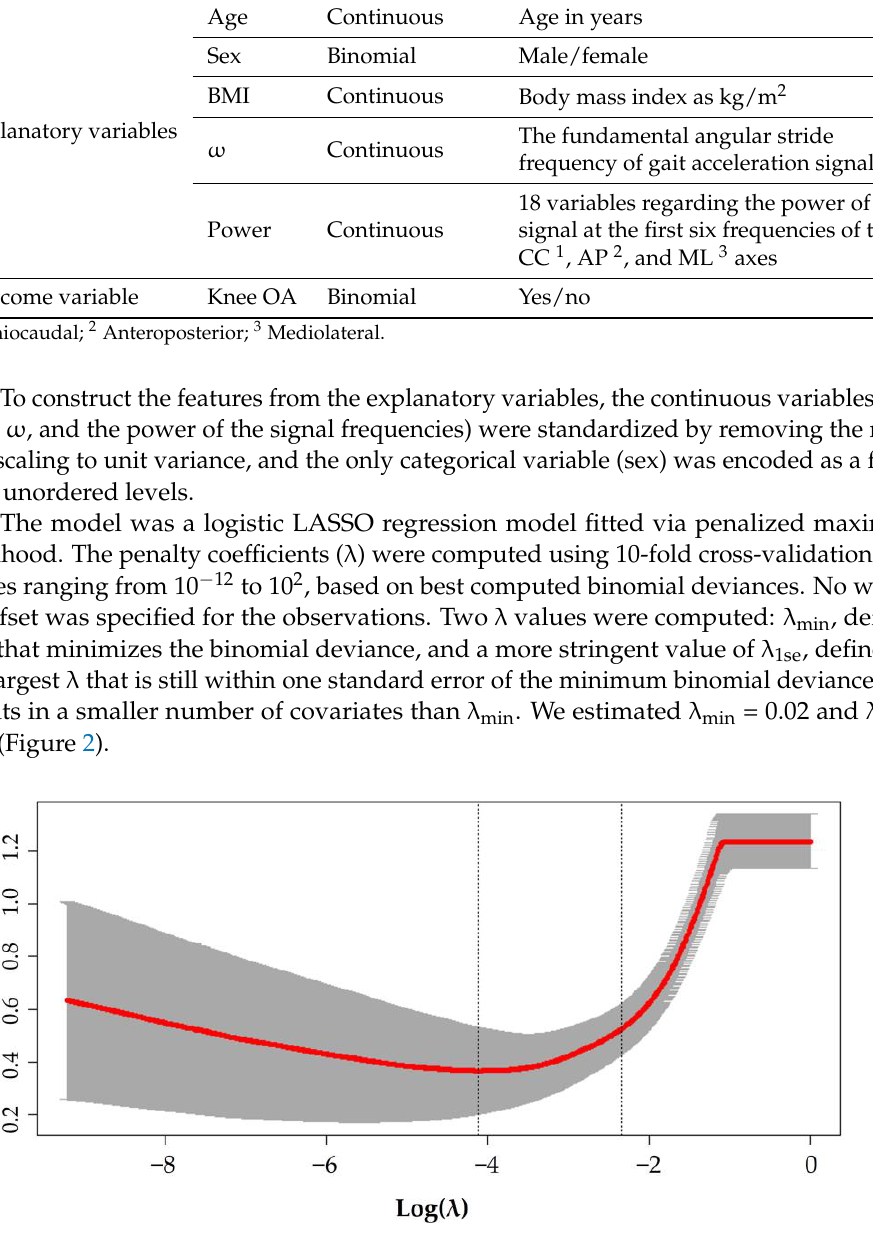
Figure 2. Cross-validation plot for the penalty coefficient ( λ ). Two vertical dashed lines correspond to the λ min and λ 1se to the left and right, respectively. The x-axis regards the logarithm of λ . The LASSO coefficients ’ 95% CI and p -values at a fixed value for the penalty param- eter ( λ = λ 1se ) were obtained using the method described by Taylor and Tibshirani [33]. Finally, the model ’ s performance in classifying the gait signals into osteoarthritic and non-osteoarthritic knees (patients vs. controls) was estimated by performing 10-fold cross- validation on divided data into 75% training and 25% validation sets. Subsequently, the mean and 95% CI were calculated for accuracy as the percentage of correctly classified instances out of all cases and Cohen’s Kappa as the measure of agreement between the actual and classified labels. We have also calculated the accuracy and Kappa for a separate logistic LASSO regression model with potential confounder variables (age, BMI, and ω) to ascertain the superior ability of the power of the frequencies than the potential con- founder variables in classifying the gait signals. 2.5. Comparing the Severity of Knee OA We used KOOS as a subjective measure to estimate the severity of individuals ’ prob- lems related to knee OA. We divided the participants into three groups using terciles (33rd and 67th percentiles) for each of the KOOS subscales (pain, symptoms, ADL, sport, and QoL): Individuals with the highest scores or no/mild knee OA (G0), individuals with scores in the middle range or moderate knee OA (G1), and individuals with lowest scores or severe knee OA (G2). We also divided the participants into three groups based on the radiographic classification of knee OA. However, since we did not perform a radiographic examination in healthy individuals, the participants in the control group, patients with KL 1 or 2, and patients with KL 3 or 4, formed G0, G1, and G2 groups for KL classification, respectively. The selected features of the logistic LASSO regression at λ = λ 1se were com- pared between three groups of participants for each KOOS subscale in addition to KL classification. 2.6. Statistical Analysis Descriptive statistics were used to describe the participants’ characteristics. The nu- merical variables (age, BMI, pain score, and KOOS) were presented as mean and standard deviation, and categorical variables (sex, KL classification, and the affected side) were shown as counts. The frequency domain features ( ω and the power of the frequencies) were described as mean and range. Since the Shapiro – Wilk normality test did not confirm normality, univariate statistical comparisons were conducted using the non-parametric Wilcoxon rank sum test. In addition, the sex between the two groups was compared with a chi-square test. The mean and 95% confidence intervals (CI) were calculated for the dif- ferences in the means of the continuous variables (age, BMI, KOOS, and the frequency